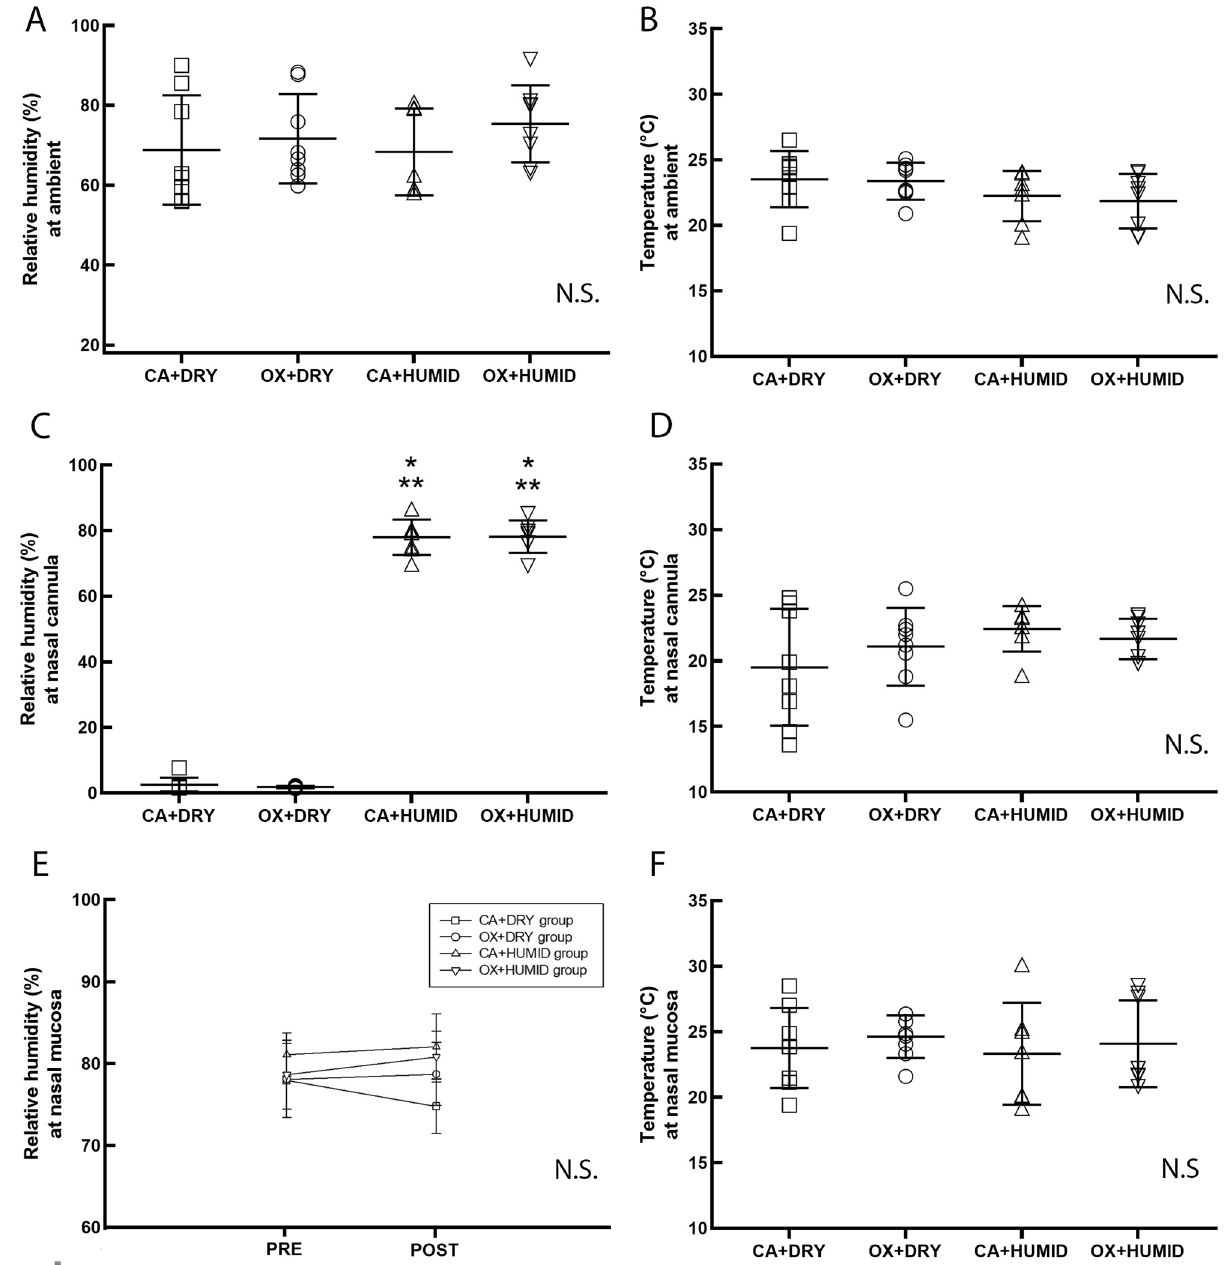
Figure 2. Relative humidity at ambient ( A ), temperature at ambient ( B ), relative humidity at nasal cannula ( C ), temperature at nasal cannula ( D ), relative humidity at nasal mucosa ( E ), and temperature at nasal mucosa ( F ). *P < 0.05 compared to CA + DRY group. **P < 0.05 compared to OX + DRY